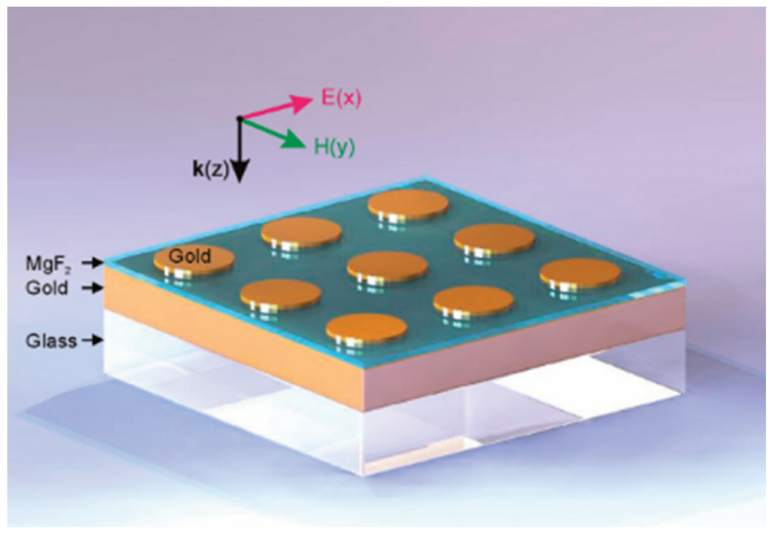
Figure 11. Nanodisk array over a 30nm MgF 2 spacer, on top of an Au film of 200 nm. Reproduced with permission from